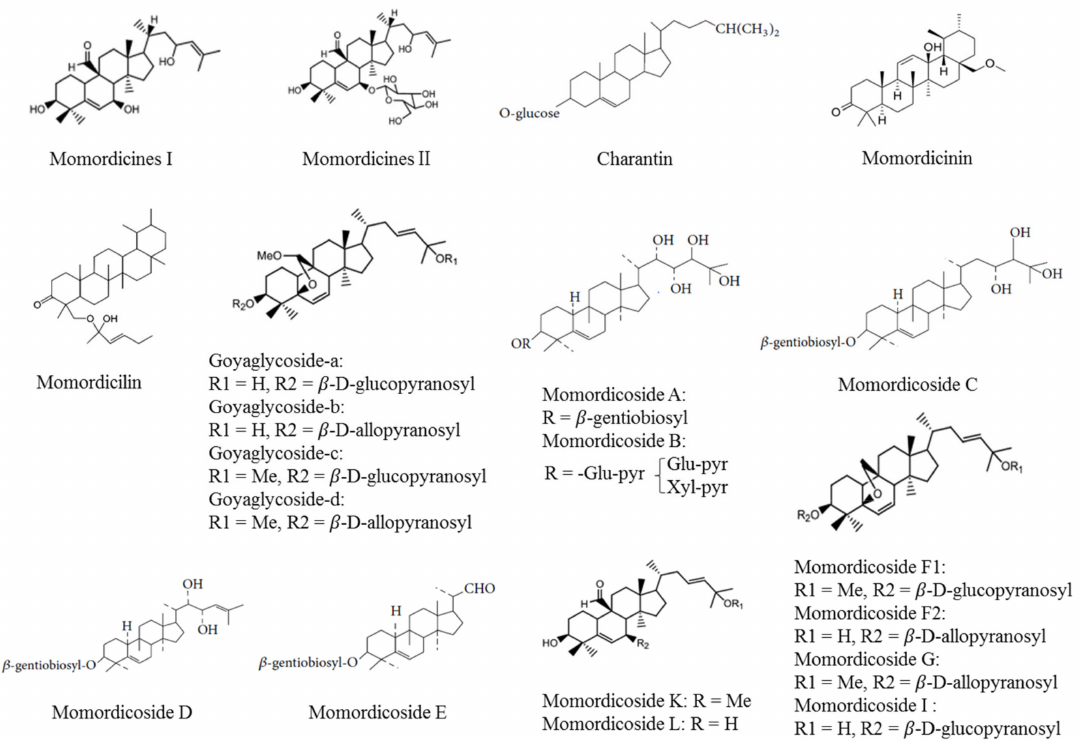
Figure 1. Chemical structure of saponins and triterpenes isolated from M. charantia